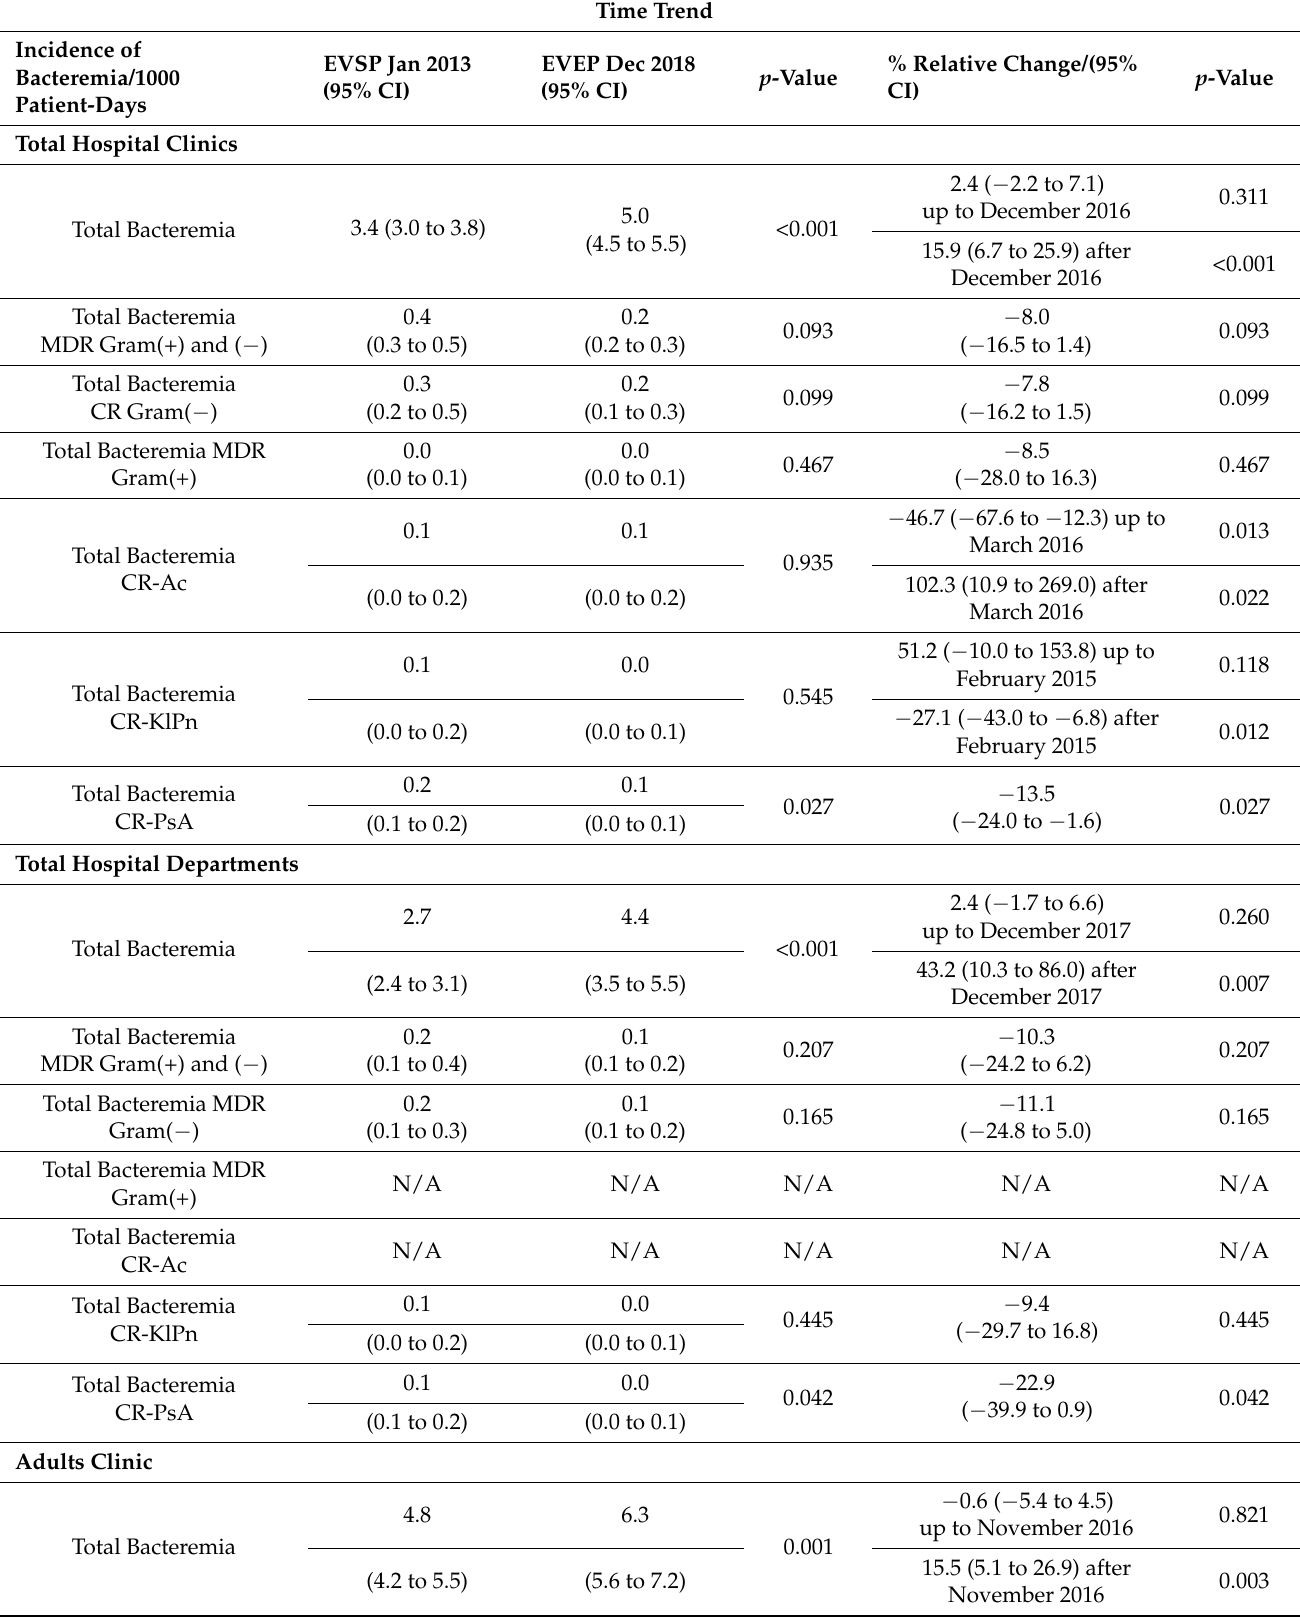
Table 4. Time trend of the incidence of bacteremia in a hospital from January 2013 to December 2018. Time